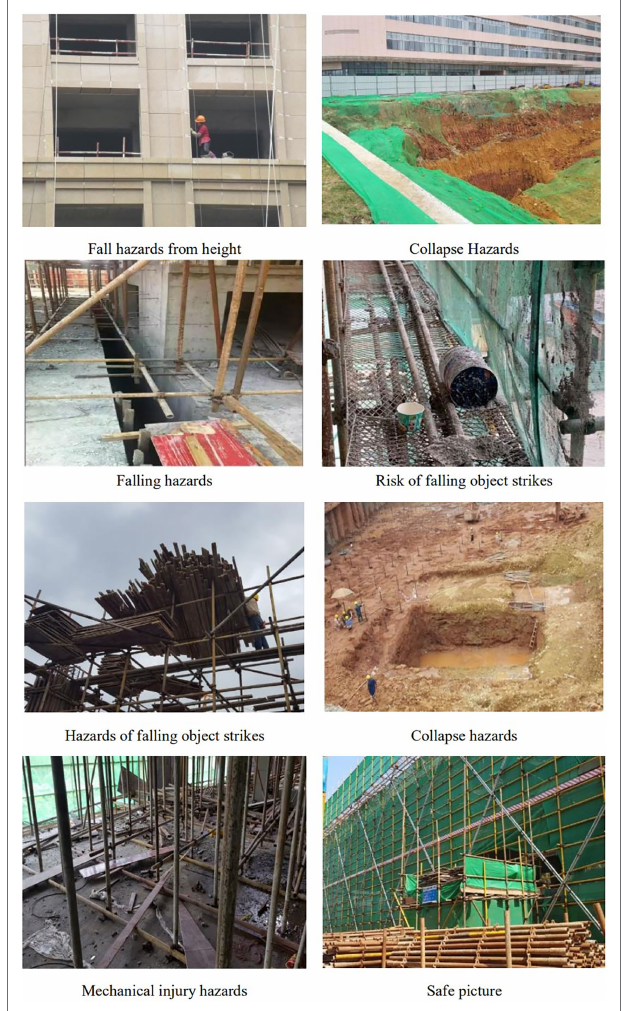
After 37 sets of experiments, each containing 3 categories of emotional stimuli, 16 pictures of safety hazards for each category, a total of 1776 data were collected. Finally, 1,650 valid data were obtained with a 92.9% validity after removing invalid